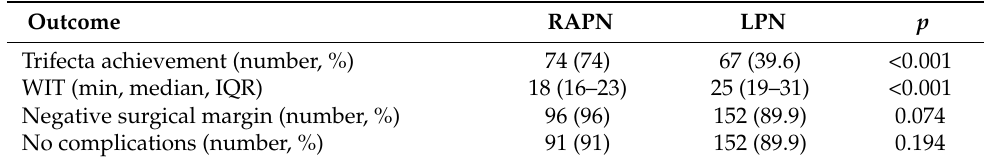
Table 4. Trifecta analysis comparing RAPN and